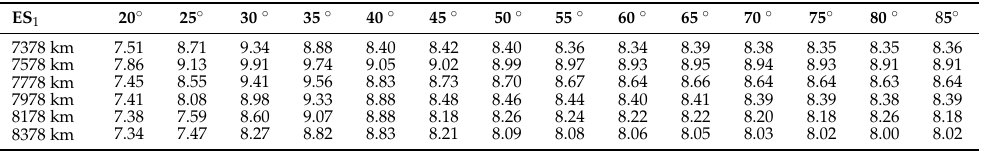
Table 5. Scale parameter of the gamma distribution, b × 10 − 2 , to characterize the elevation angle distribution at ES 1 , for different altitudes, h , and orbit inclinations, i